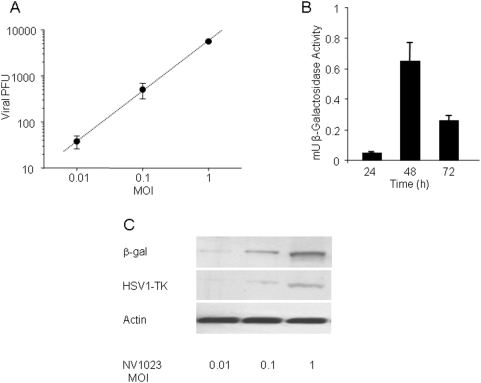

In vitro β-galactosidase and HSV-1TK transgene expression over time.(A) Viral amplification assay. Cells were infected with NV1023 at MOIs of 0.01–1 and viral titers measured at 48 hours. NV1023 demonstrated highly efficient replication in B16-F10 melanoma cells within 48 hours after infection. (B) β-galactosidase activity in B16-F10 melanoma cells at 24, 48, and 72 hours after infection with NV1023. (C) Western blotting analysis performed 48 hours after viral infection at MOIs of 0.01–1 revealed that expression of β-galactosidase was correlated with HSV1-tk expression in melanoma cells.